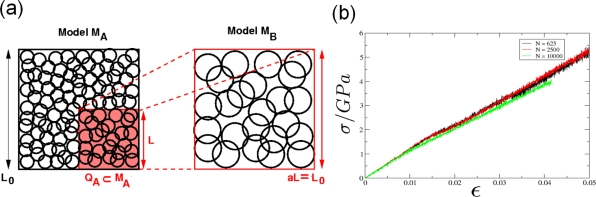
(a) Schematic of the intrinsic scaling property of the proposed material model. Here, only the 2D case is shown for simplicity. The original system (Model Ma) with edge length L0 and particle radii R0 is downscaled by a factor of 1/a into the subsystem QA of MA (shaded area) with edge length L, while the particle radii are upscaled by factor a. As a result, model MB of size aL = L0 is obtained containing much fewer particles, but representing the same macroscopic solid, since the stress-strain relation (and hence, Young’s modulus E) upon uni-axial tensile load is the same in both models. (b) Young’s modulus E of systems with different number of particles N in a stress-strain (σ–ε) diagram. In essence, E is indeed independent of N.